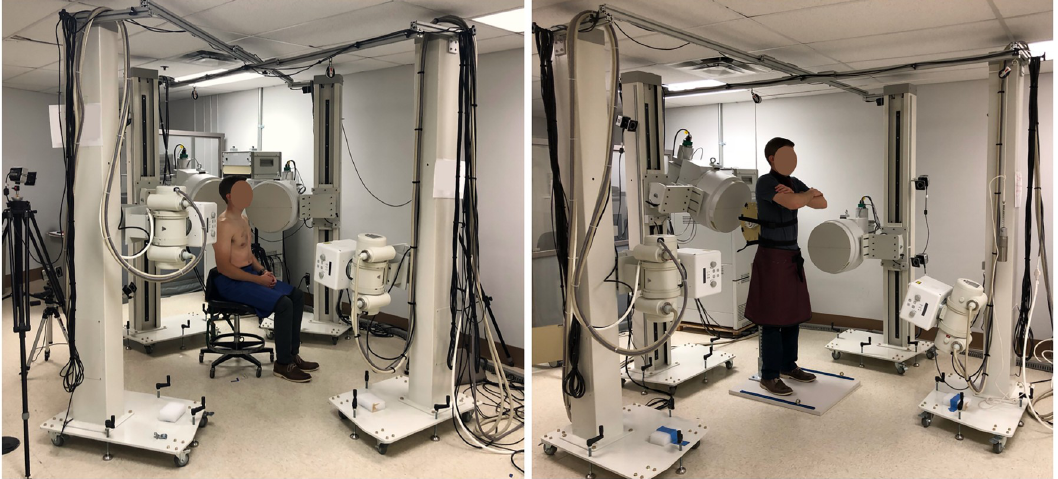
Fig 2. Biplane radiography setup. (Left) Cervical spine setup with two offset systems and interbeam angle of 55˚, 16” image intensifiers and high-speed cameras. One system is oriented parallel to the horizontal and the other is oriented above the horizontal. (Right) Lumbar spine setup with attached attenuator and orthogonal systems. One system is oriented parallel to the horizontal and the other is oriented above the horizontal Note : Validation was performed using a cadaveric specimen; however , the setup is demonstrated with a live subject . Lumbar acquisition was performed with the cadaveric specimen inverted and the AP system oriented 8° above the horizontal